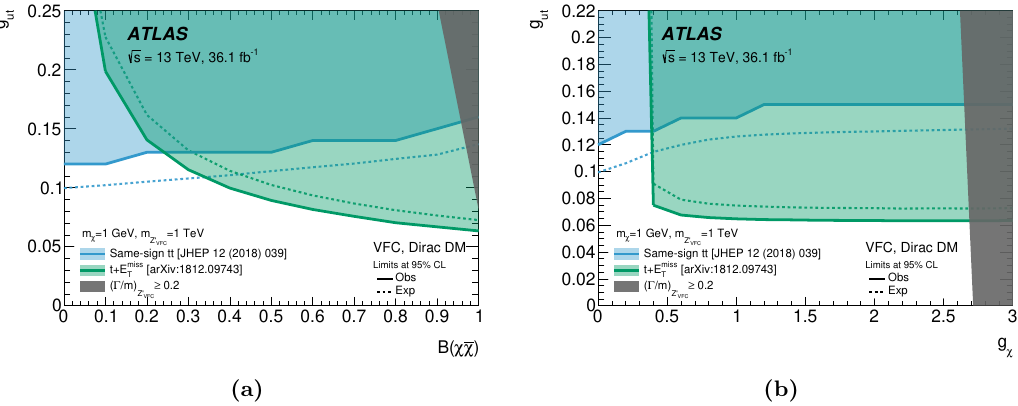
Figure 16. Exclusion limits from the t + E miss and same-sign tt analyses for the VFC model as a T function of the SM coupling g ut and (a) the DM branching ratio or (b) the DM coupling g (cid:31) . The observed exclusion is indicated for each of the two analyses by the (cid:12)lled area. The mass of the DM particle is set to 1 GeV and the mass of the Z 0 boson is set to 1 TeV. The dark shaded area VFC corresponds to an invisible partial width of the mediator above